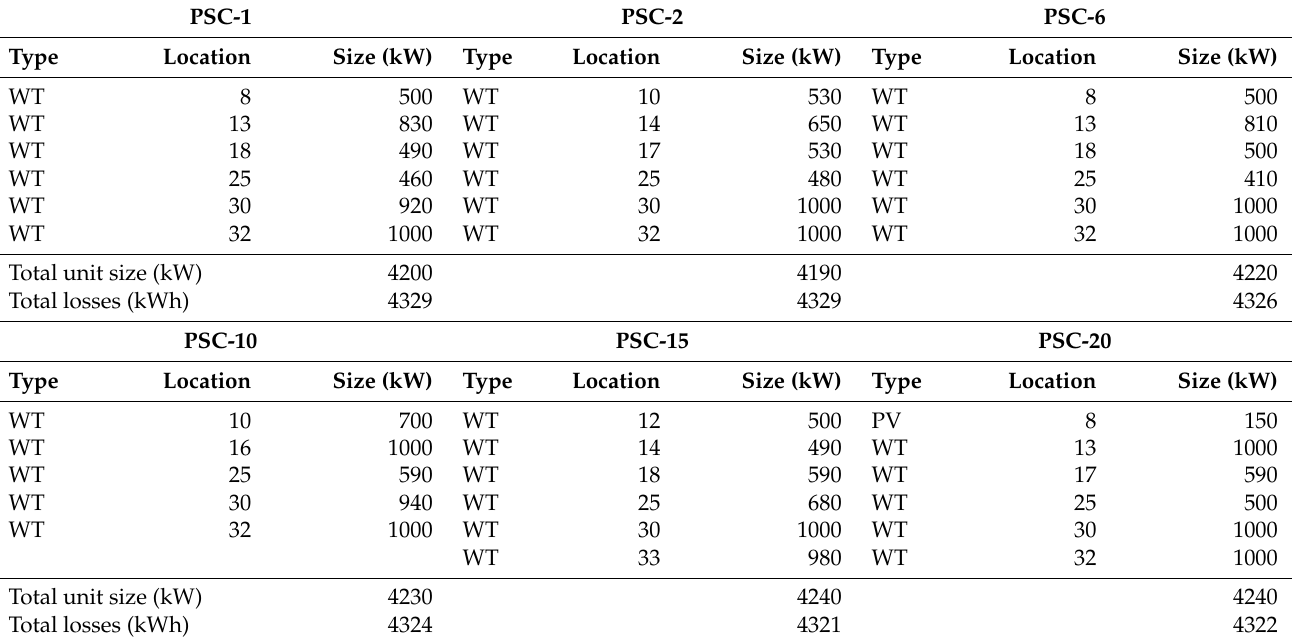
Table 6. The units’ size and location for the PSCs.